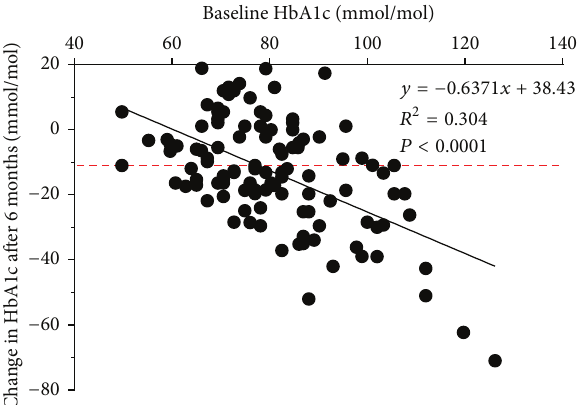
Figure 2: Relationship between the baseline HbA1c and changes in HbA1c after six months of exenatide therapy. Results are shown with the equation for the line of best fit, the 𝑅 2 value quantifying the goodness of fit, and the 𝑃 value showing statistical significance. Dashed line indicates the 11mmol/mol point which is the reduction required for individuals to be classed as responders to exenatide.